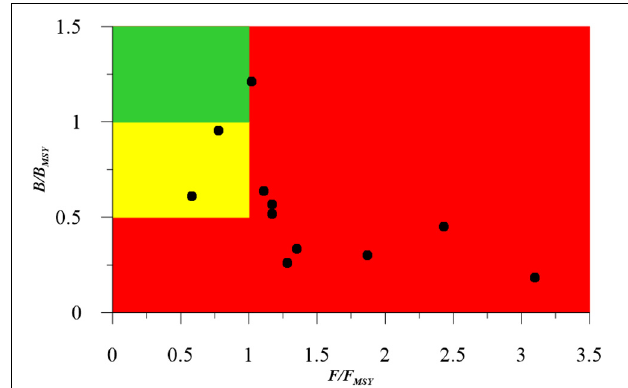
FIGURE 4 | Presentation of 11 stocks in Japan Sea in a pressure ( F/F MSY )–stock state ( B / B MSY ) plot, for the last years with available data (2016–2017). Red area: stocks that are being overfished or are outside of safe biological limits; yellow area: recovering stocks; green area: stocks subject to sustainable fishing pressure and of a healthy stock biomass that can produce high yields close to MSY.